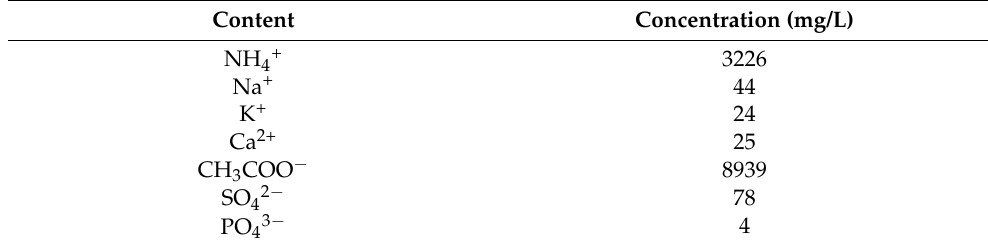
Table 1. Composition of the condensate water samples.